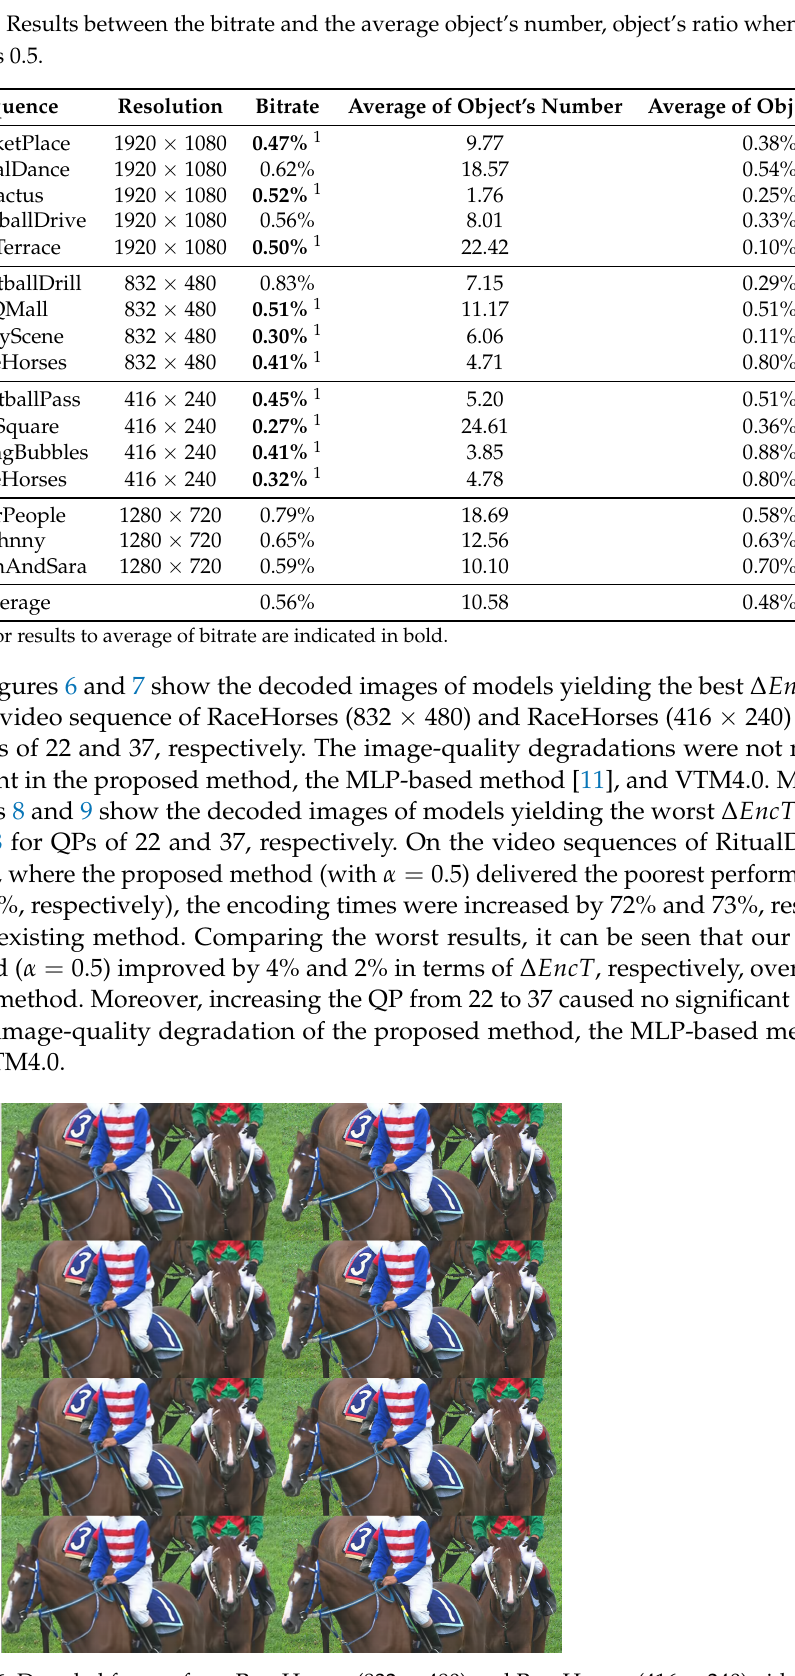
Figure 6. Decoded frames from RaceHorses (832 × 480) and RaceHorses (416 × 240) videos yielding the best ∆ EncT results presented in Table 8 when QP =